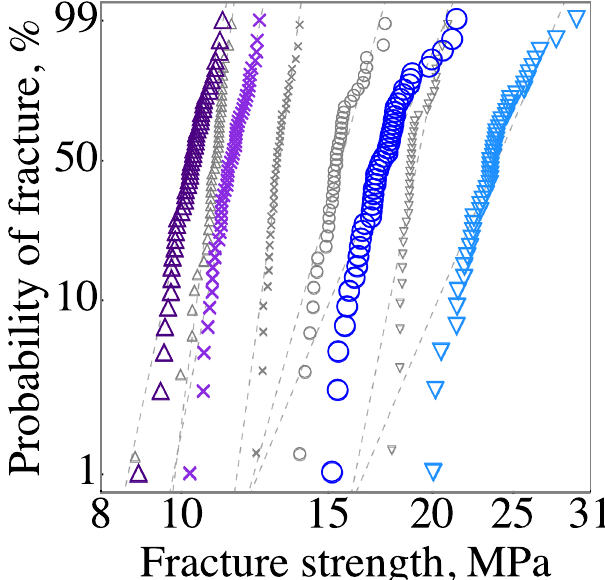
Figure 9. Weibull plot showing the simulated fracture strength (larger and colored markers) and experimental (gray markers) for P (vol.%) = 53 Δ , P = 41 × , P = 34 ◯ , and P = 25 ∇